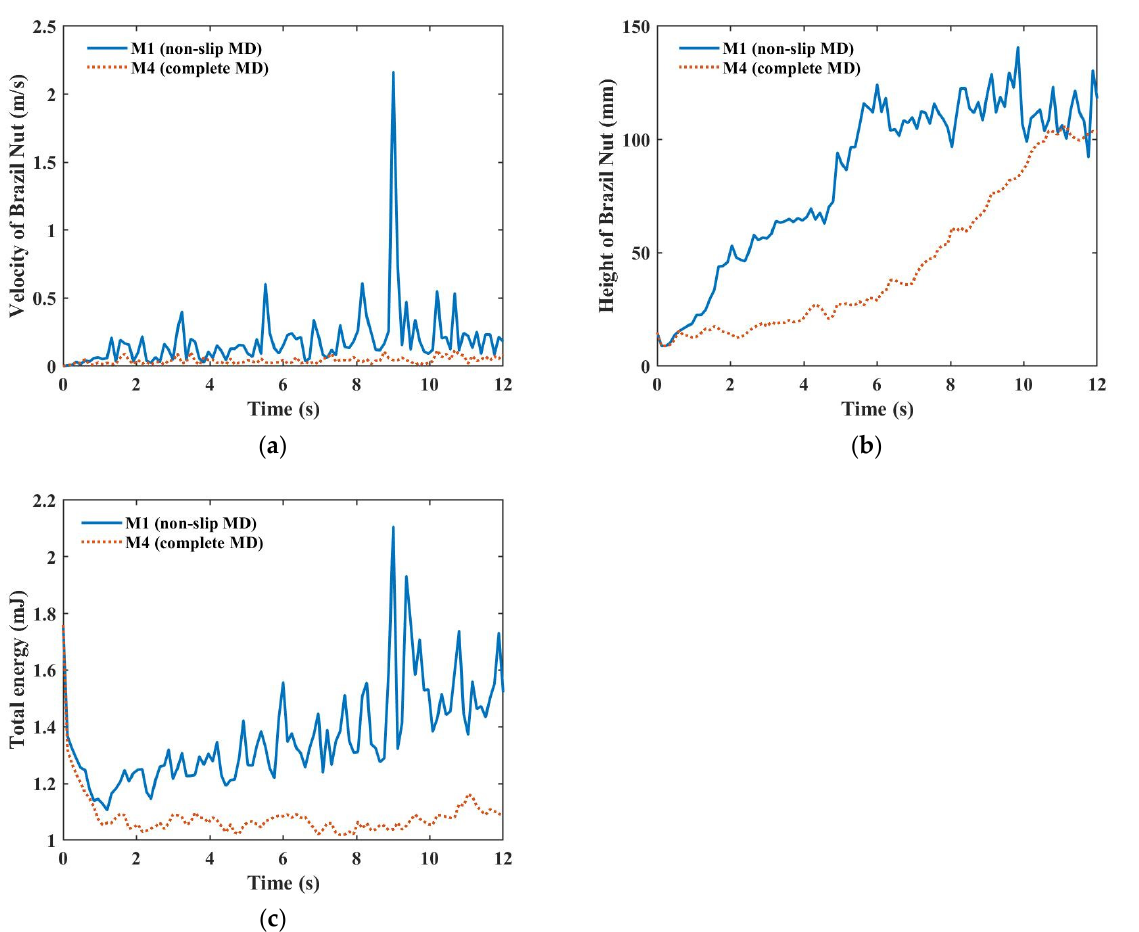
Figure 10. Comparison between M1 and M4 by applying the Brazil nut effect. ( a ) velocity of the Brazil nut; ( b ) height of the Brazil nut; ( c ) total energy .